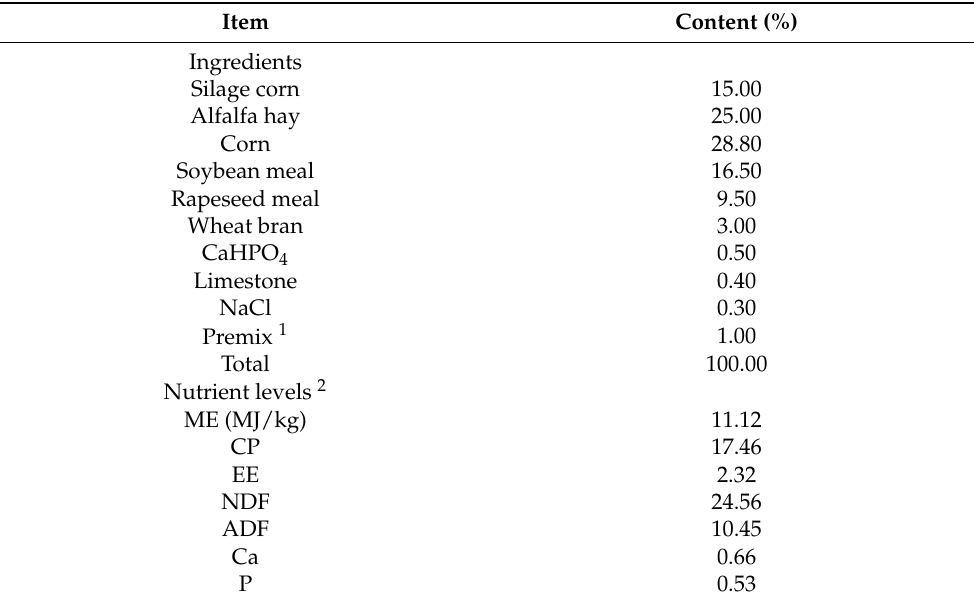
Table 1. Composition and nutrient levels of the basal diet (as-fed